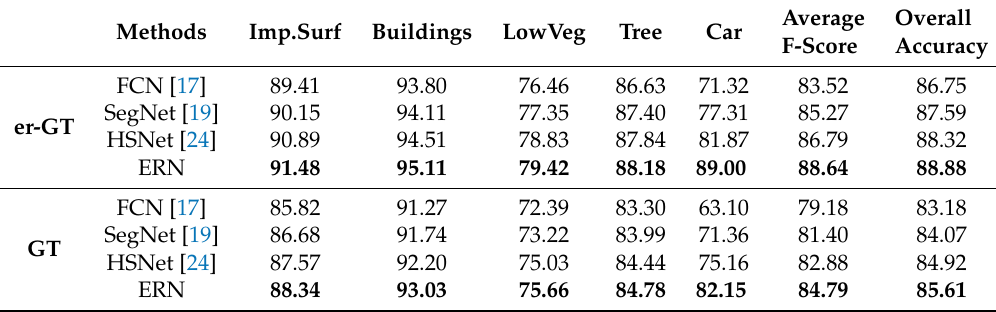
Table 5. Experimental results on the ISPRS Vaihingen Dataset. er-GT: eroded ground-truth; Imp.Surf: impervious surface; LowVeg: low vegetation.